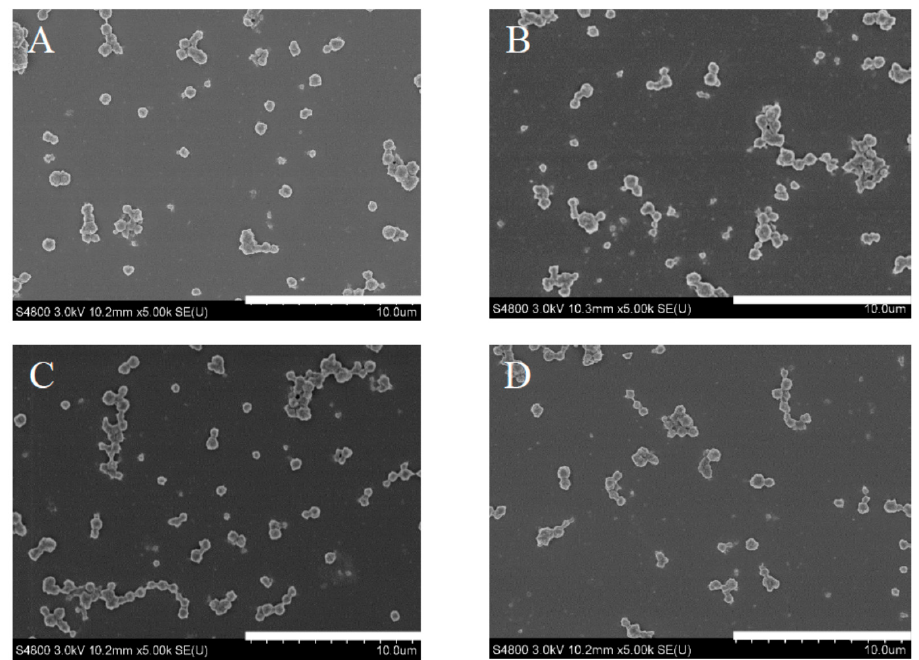
Figure 1. Scanning electron micrographs of silk nanoparticles. ( A ) Pure Ap F nanoparticles; ( B ) DOX- Ap F nanoparticles; ( C ) Ibuprofen- Ap F nanoparticles; and ( D ) Ibuprofen-Na- Ap F nanoparticles. The fibroin concentration was 10 mg/mL. Scale bar = 10 µm.